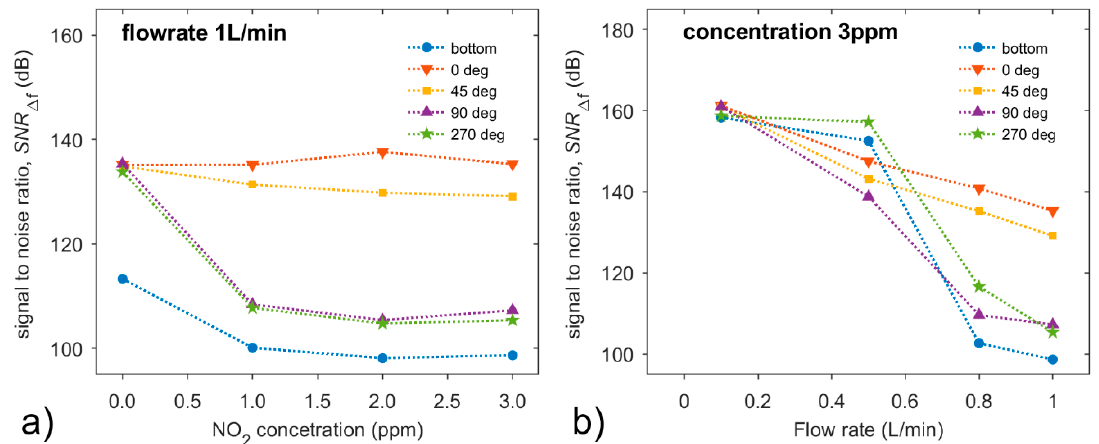
Figure 16. Dependences of signal-to-noise ratio ( a ) on NO 2 concentration at the constant flow rate of 1 L/min, or ( b ) on the flow rate at the constant concentration of 3 ppm, at the orientations of sensor - 0°, 45°, 90° and 270°. Conditions: 298 K, 40%RH.